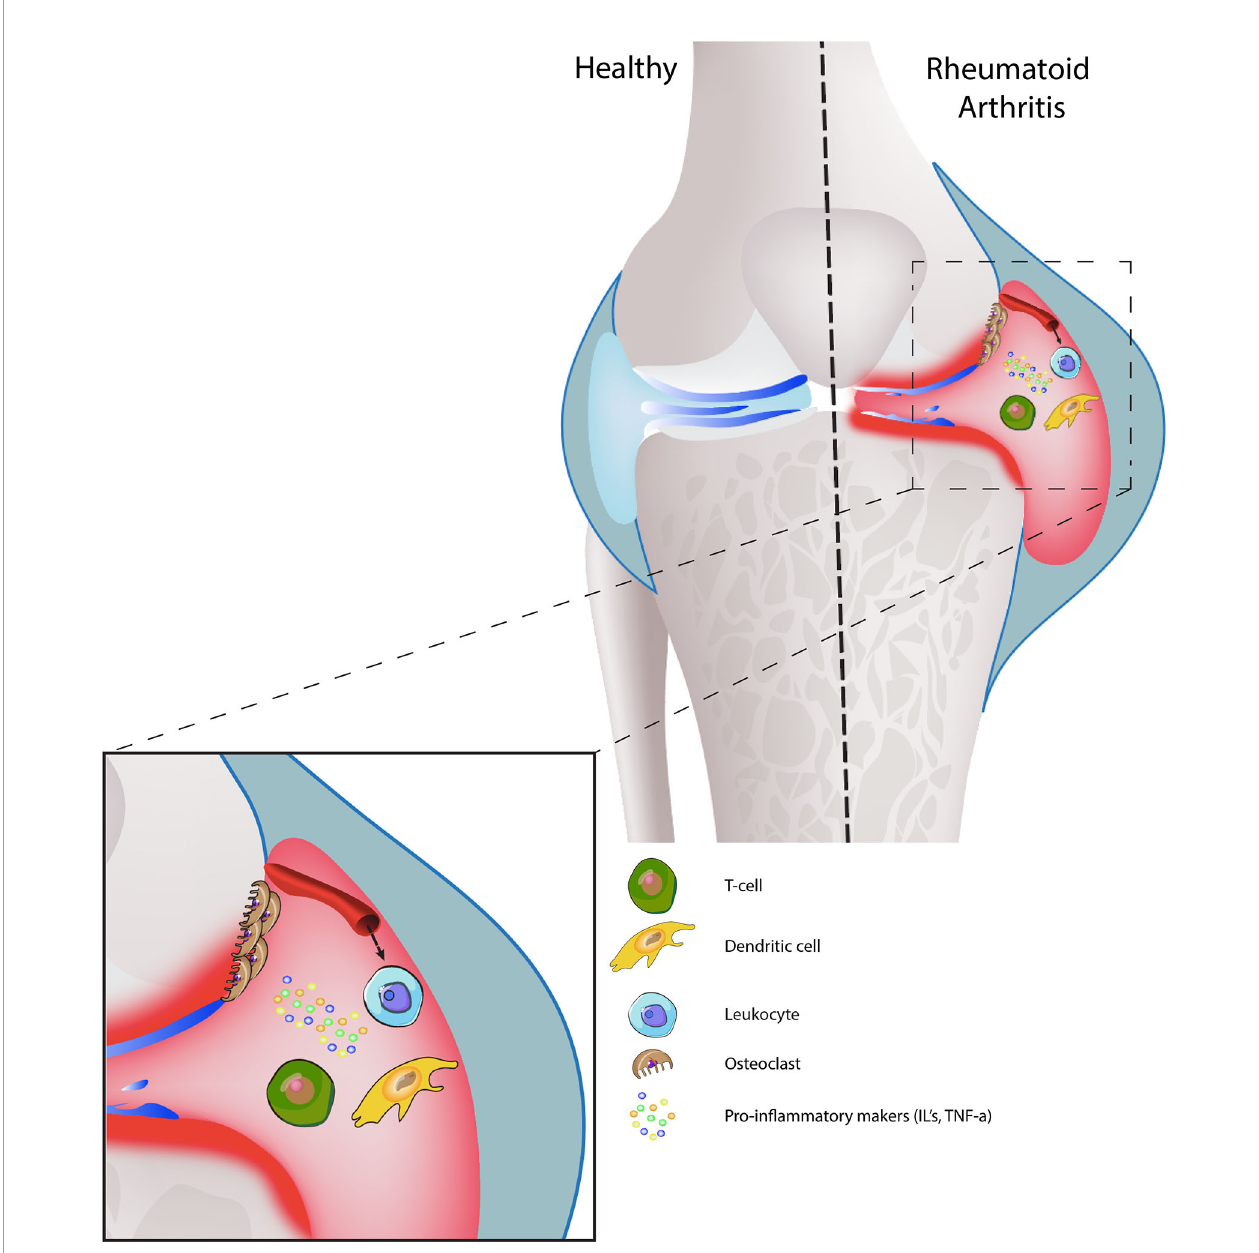
FIGURE 3 | Joint synovium in healthy and diseased condition: Healthy joint synovium displays a thick layer of cartilage, medium synovial fl uid levels in the joint cavity with intact synovial membrane and a strong, smooth outer bone layer (top left). In RA, the synovial membrane is swollen and has a high presence of synovial fl uid, which leads to damaged bone and cartilage (top right). On the cell-interaction level, increased leukocyte in fi ltration promotes in fl ammation, hyperplasia, and bone destruction by osteoclasts. Dendritic-T cell interactions also release pro-in fl ammatory markers, which further enhances disease